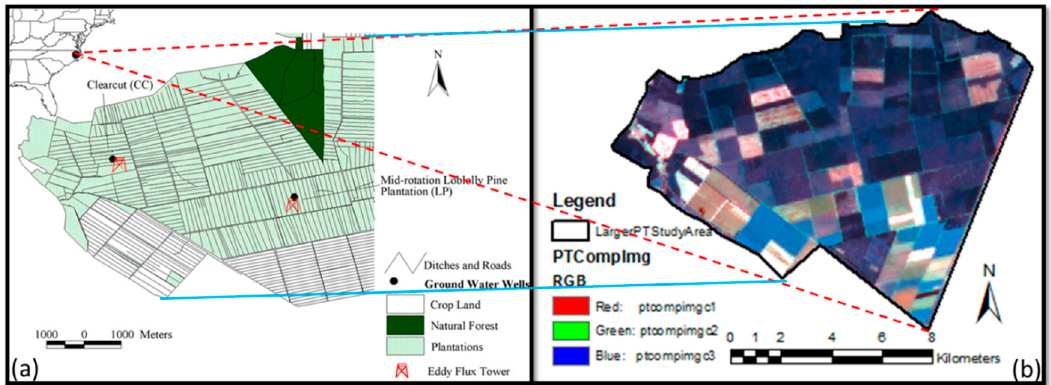
Figure 1. Study area location and instrumentations for climatologic data acquisition and hydrological monitoring—( a ) Study area plot design and ( b ) False Color Composite (FCC) Landsat Image of the study area. Note: PTCompImg in Figure 1b = PT (larger) site Composite Image.